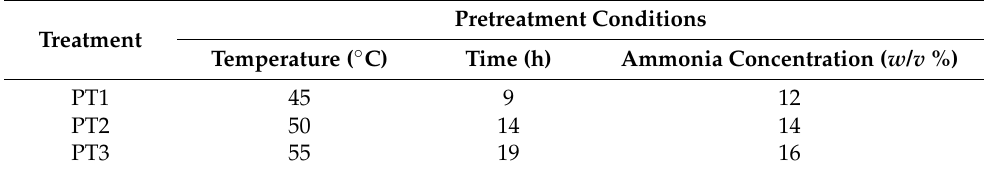
Table 1. Pretreatment conditions modeled for loose and pelleted biomass scenarios (selected from [5]).